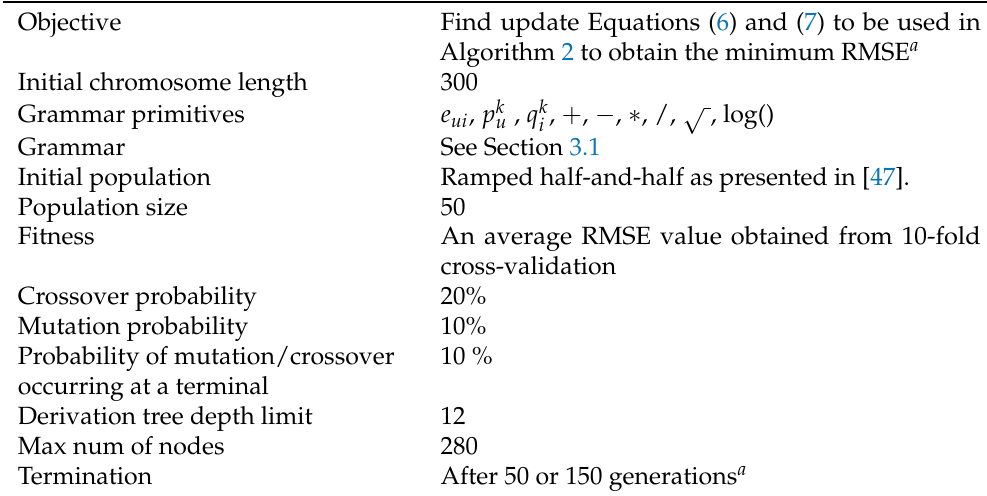
Table 5. Summary of parameters used for our grammatical evolution run. Objective Find update Equations (6) and (7) to be used in Algorithm 2 to obtain the minimum RMSE